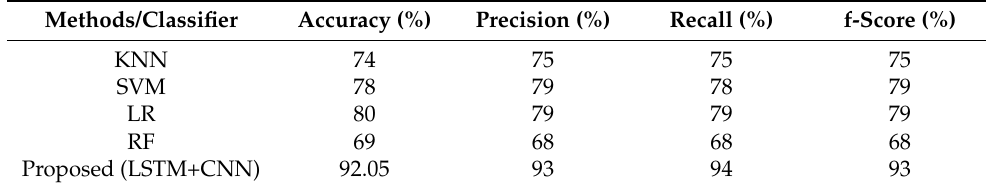
Table 11. Performance comparison of the suggested model (LSTM+CNN) versus machine learn- ing